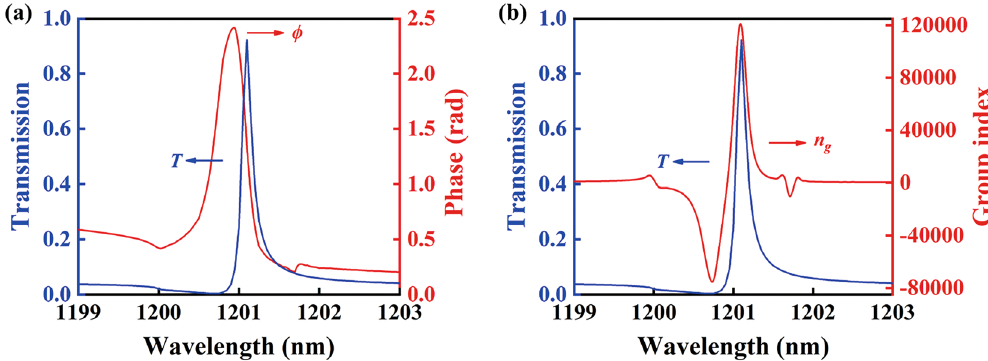
Figure 4. Slow light effect of bilayer plasmonic waveguide structure. ( a ) Calculated phase change (red line) is shown together with transmission spectrum (blue line). ( b ) The resulting group index around transmission